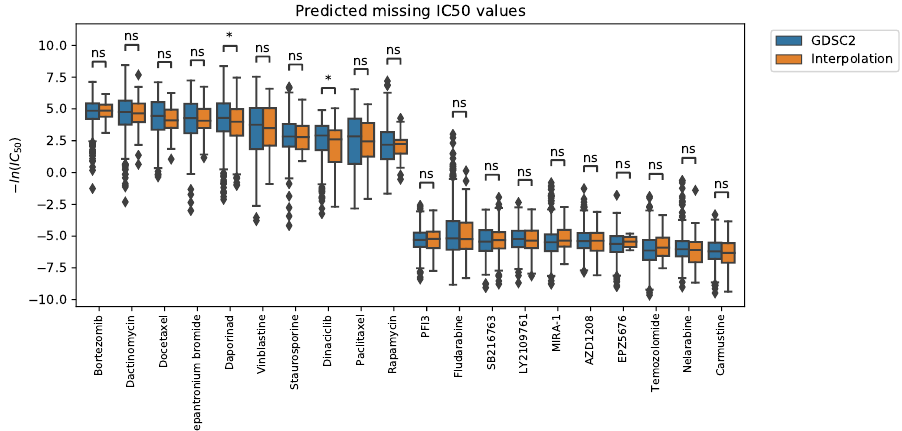
Figure 2. Box plot of drug-specific IC50 distributions of cell lines. The distribution of GDSC2 data (blue) compared with predicted missing IC50 values (orange). The 10 drugs with the highest median IC50 values and the 10 drugs with the lowest median were selected. Among the 20 drugs, IC50 value distributions of 18 drugs showed no significant differences through the Mann–Whitney Wilcoxon Test. ns: not significant, *: 0.01 < p -value <